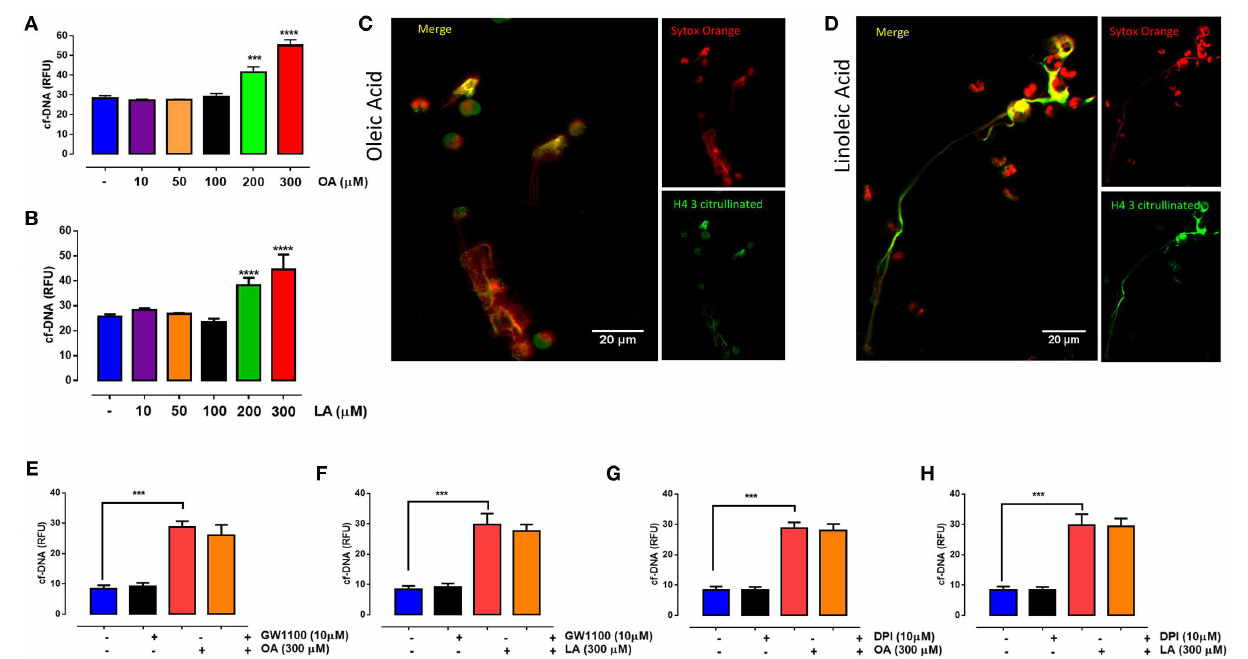
FIGURE 1 | Oleic acid (OA) and linoleic acid (LA) induce neutrophil extracellular trap (NET) formation independently of FFAR1 and NADPH oxidase activation. Bar graph (means ± S.E.M.) showing the relative fluorescence (RFU) of cell-free (cf)-DNA obtained from PMN treated with different concentrations of OA (A) or LA (B) . Immunofluorescence of PMN treated with a 300 µ M concentration of OA (C) or LA (D) using an anti-histone H4 citrulline 3 antibody as a NET marker and Sytox orange as a DNA marker. Images are representative of four independent experiments; scale bar = 20 µ M. Bar graph of RFU (means ± S.E.M.) of cf-DNA